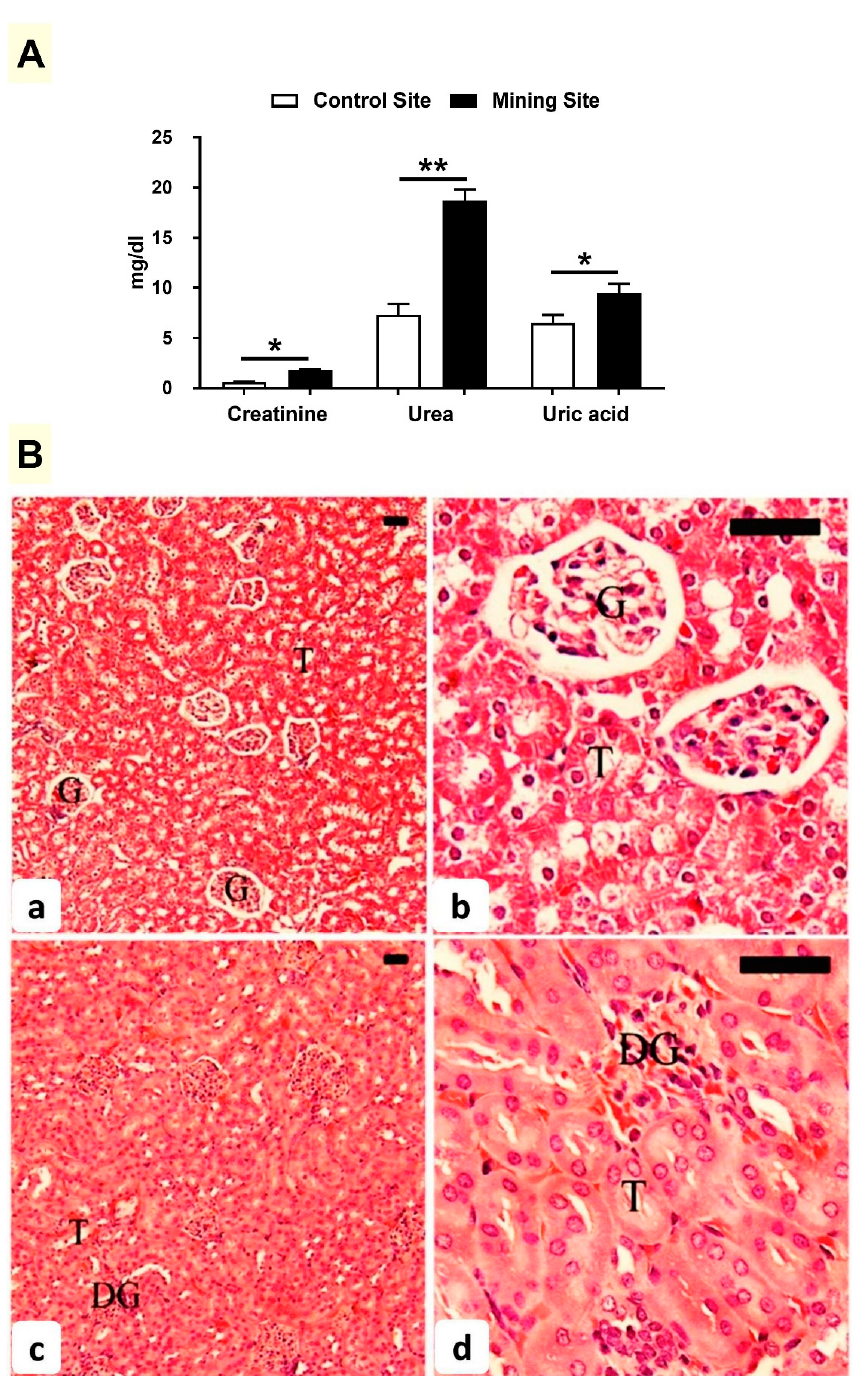
Figure 5. ( A ) Effect of mining activities on renal function markers of G. nanus . Data are means ± SEM, ( n = 8). * p < 0.05 and ** p < 0.01. ( B ) Photomicrographs of H&E-stained sections in the kidney of G. nanus from the control site ( a , b ) showing normal structure of the glomeruli (G) and renal tubules (T); and animals from the mining site ( c , d ) showing degenerated glomeruli (DG). Scale bar = 100 μ m.